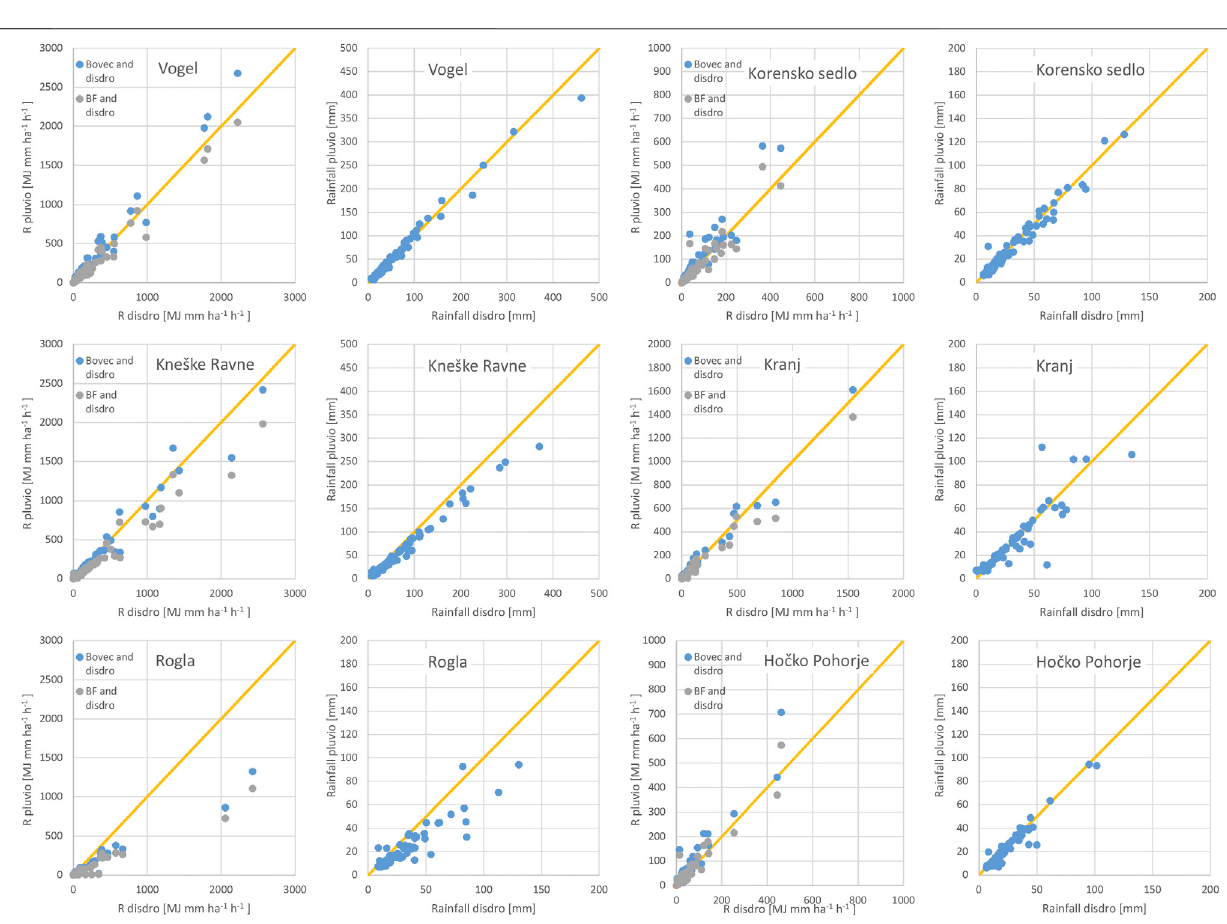
Frontiers in Environmental Science |